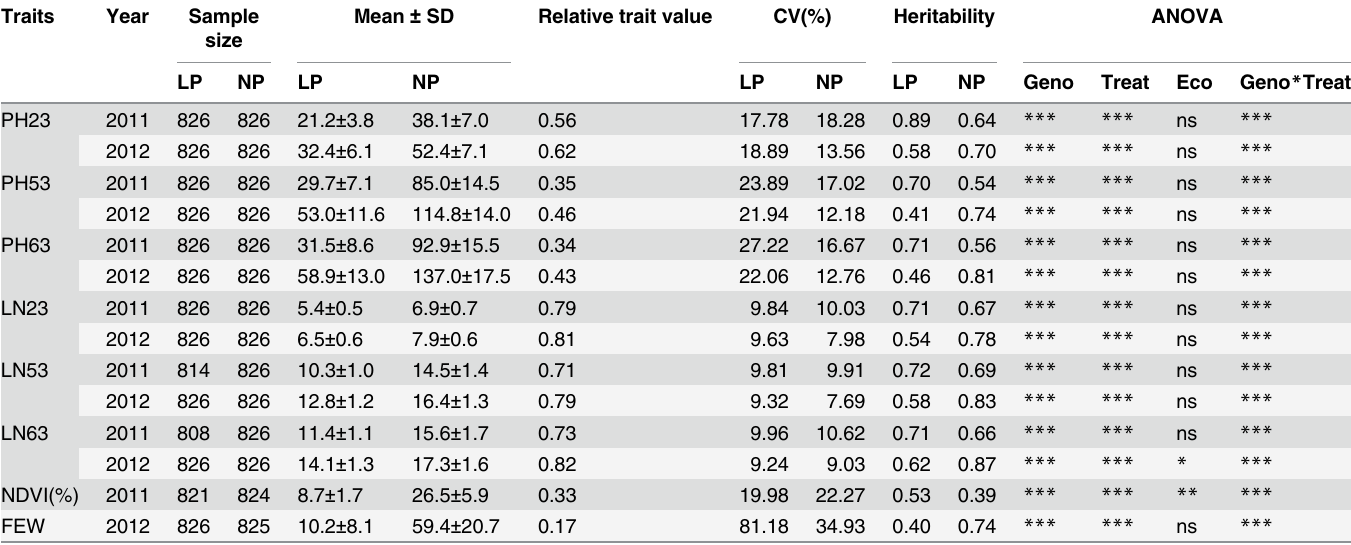
Table 2. Means and heritabilities for the tested traits under different P conditions. Traits Year Sample